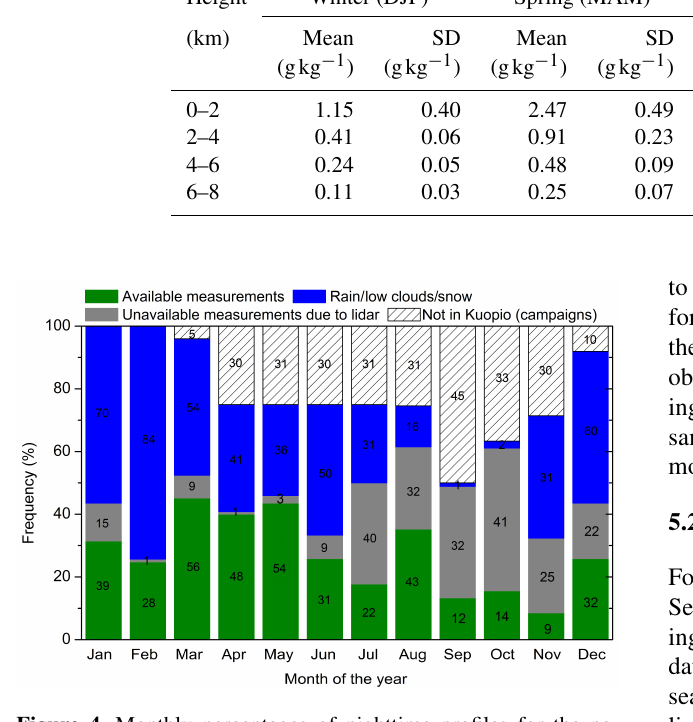
Profiles were averaged over 30 min in time and the applied vertical smoothing is the same as that described in Sect.